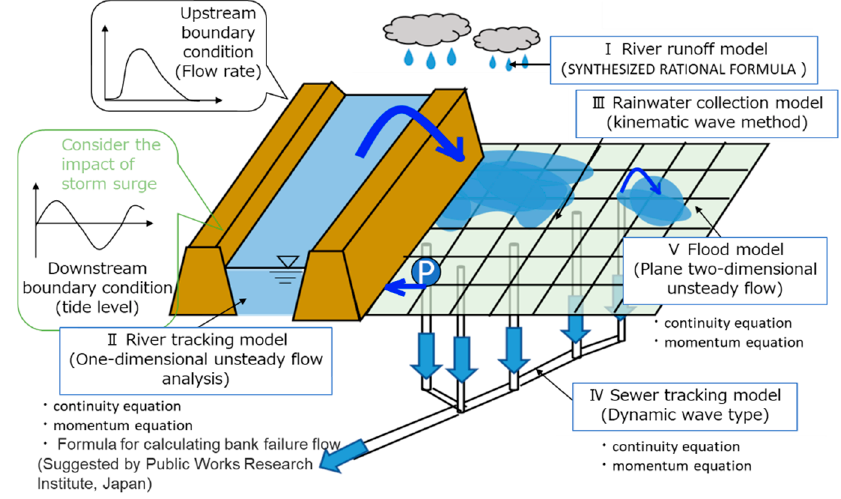
Figure 6. Conceptual diagram of simultaneous analysis model of internal and external water.